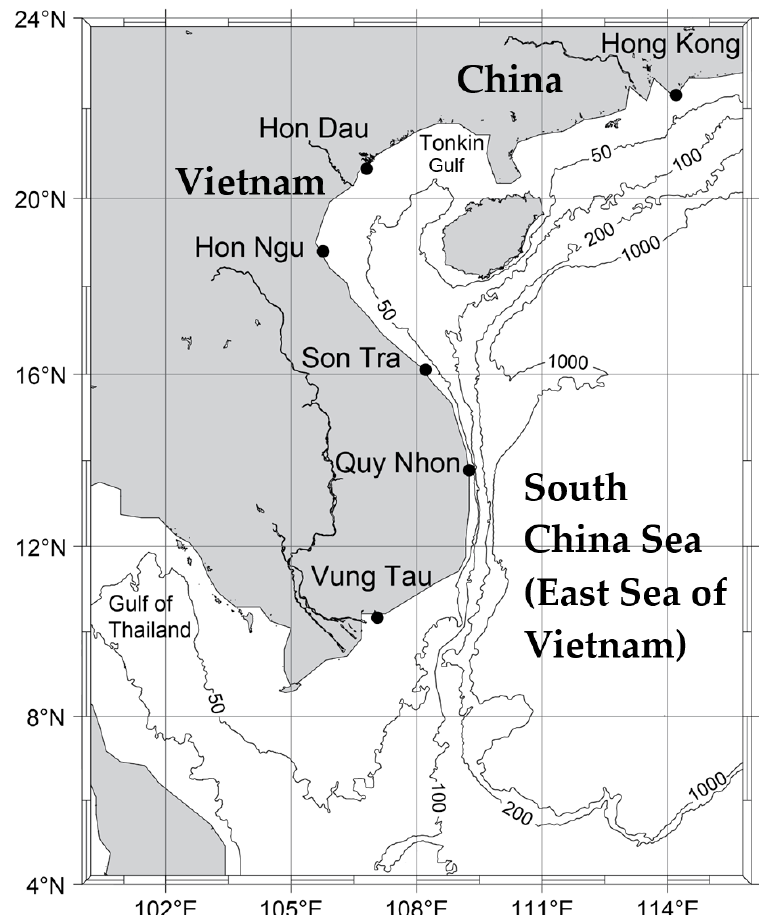
Figure 2. Location of the study region showing the locations of sea level measuring stations.